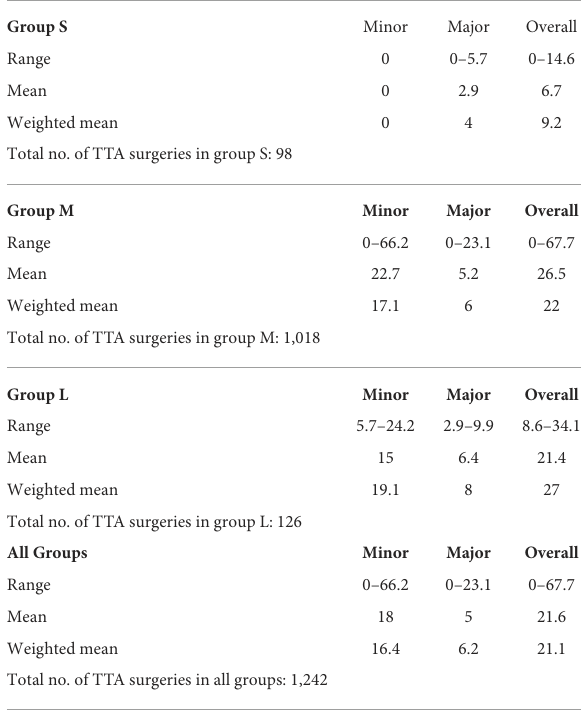
TABLE 6 Complication rates in percent for